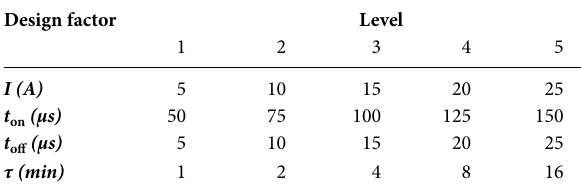
Table 3. EDM design